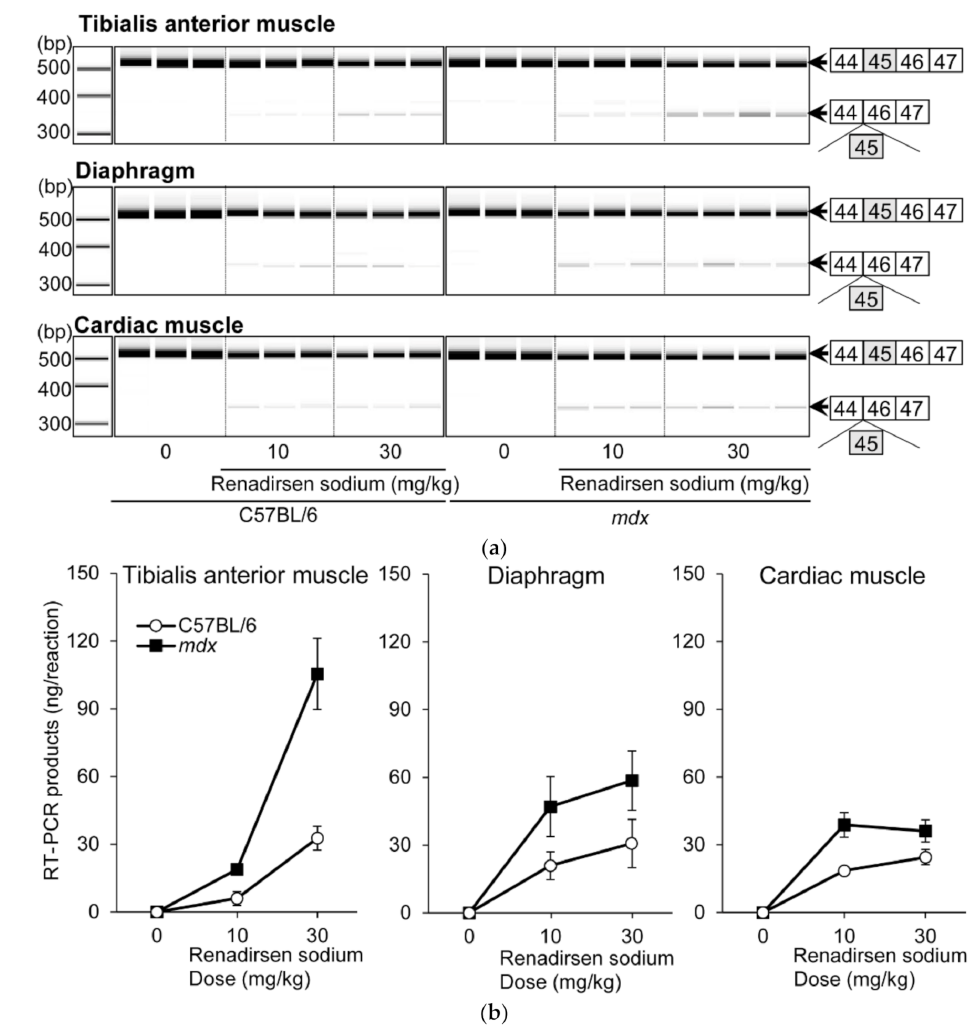
Figure 2. Exon 45 skipping in C57BL/6 and mdx mice after single s.c. administration of renadirsen sodium. ( a ) Detection of exon-45-skipped RT-PCR products of dystrophin mRNA in C57BL/6 and mdx mouse muscles after single s.c. administration. Total RNA was isolated from tibialis anterior muscle, diaphragm, and cardiac muscle. The structure of each PCR product is schematically shown at the right of the panel. ( b ) The concentrations of exon-45-skipped RT-PCR products of dystrophin mRNA from tibialis anterior muscle, diaphragm, and cardiac muscle were calculated using an Agilent 2100 Bioanalyzer. Data in (B) are shown as means ± SEM; n =